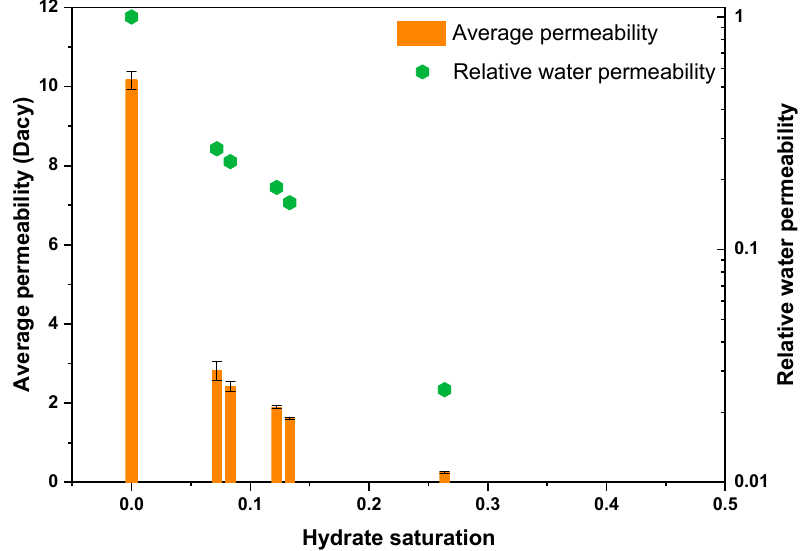
Figure 5. Permeability of hydrate-bearing sediments formed from CO 2 + N 2 gas.